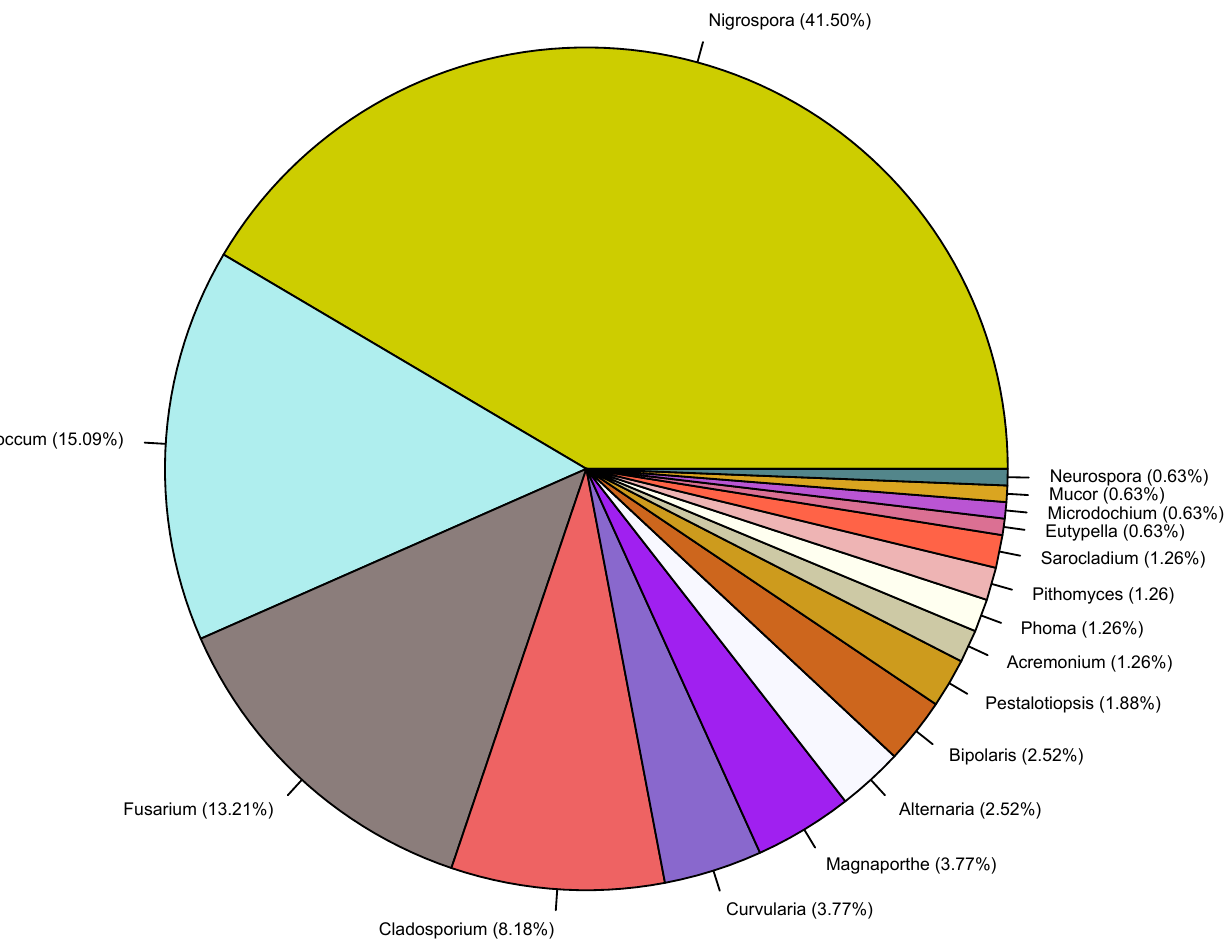
Figure 4. Occurrence of fungal genera in rice leaf and neck tissues collected from Busia, Kirinyaga, and Kisumu counties of Kenya surveyed in